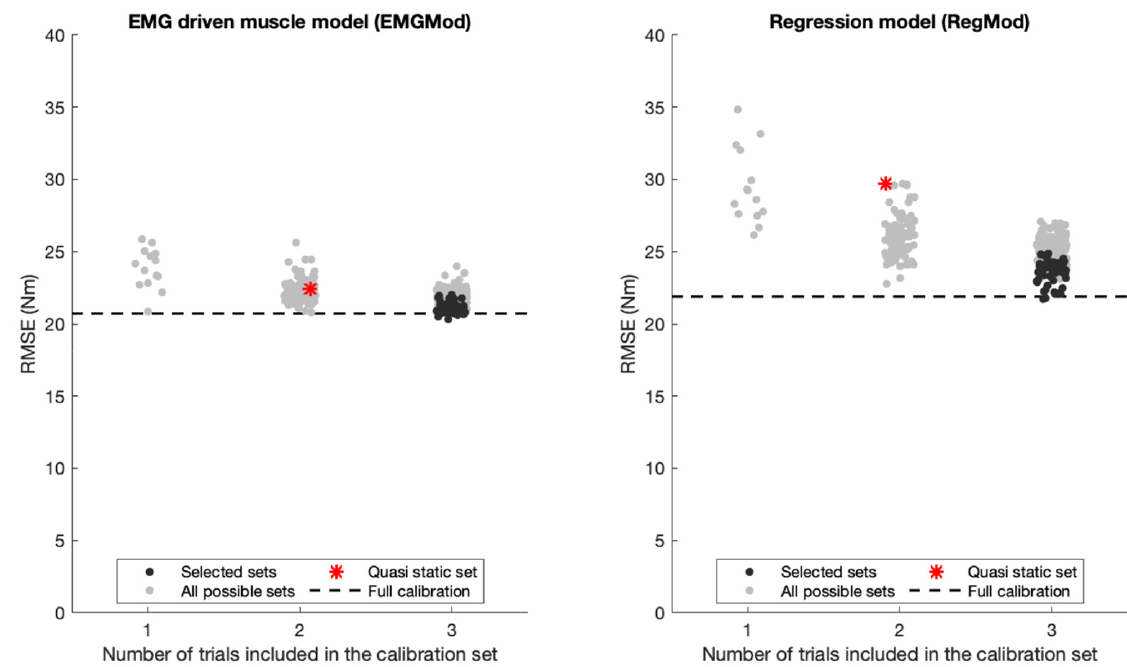
Figure 5. Examples of lumbar spine moment prediction during symmetric box lifting task. The reference values were determined by inverse dynamics, and the predictions were made by EMG- Mod and RegMod. The predictive accuracy for EMGMod and RegMod varied for different subjects, trials, and calibration sets. These examples were selected to illustrate the inverse relationship be- tween the predictive quality and the RMSE of the models.